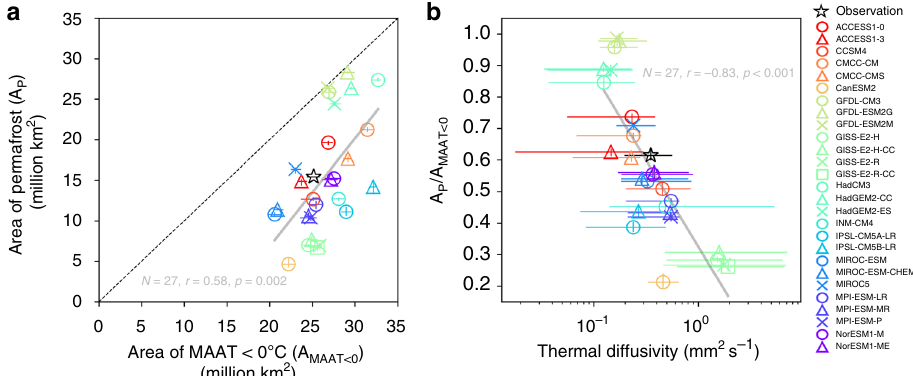
Fig. 2 Relationship between permafrost area and thermal diffusivity in the CMIP5 models. a Modelled area of regions with surface mean annual air temperature (MAAT) less than 0°C (A MAAT<0 ) and area of near-surface permafrost ( A p , see “ Methods ” section) during the period 1961 – 1990, from the historical runs of CMIP5 models. Models from the same institute are shown in the same color. The error bars indicate 25th – 75th percentiles among the 30 years. The black star indicates observations derived from CRU TS v3.24 climate dataset 65 and the IPA (International Permafrost Association) continuous and discontinuous permafrost extent 33 . b Area ratio between near-surface permafrost and regions with MAAT ≤ 0°C ( A p / A MAAT<0 ) during the period 1961 – 1990, against median thermal diffusivity from each CMIP5 model at the same site-years as the observations, with the horizontal error bars indicating 25th – 75th percentiles. The solid grey line in ( b ) represents the linear regression line between A p / A MAAT<0 and log 10 ( D ) for CMIP5 models ( y = − 0.55× +